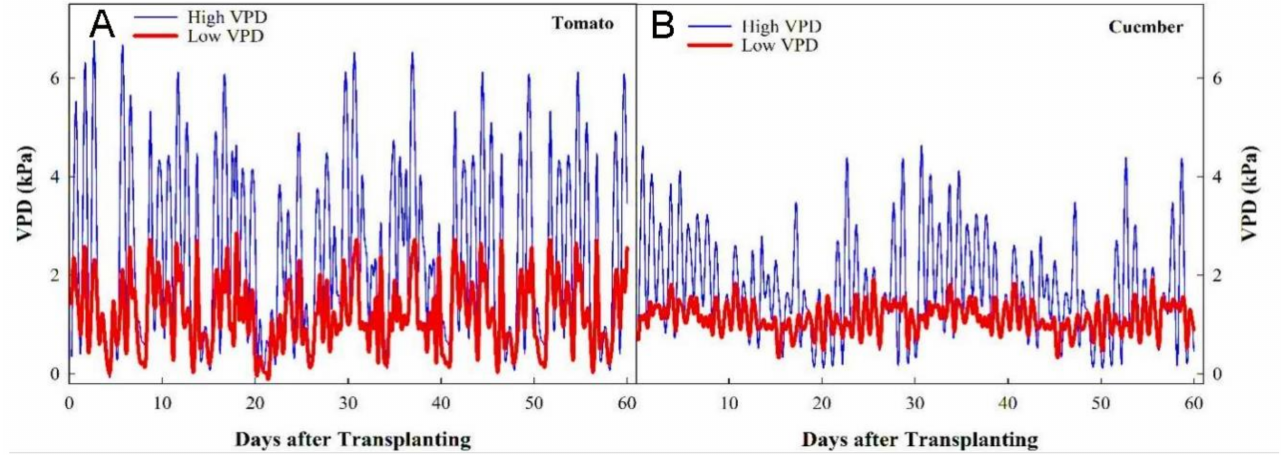
Figure 1. Experimental greenhouse environmental parameters. ( A ): Tomato plants were grown from 7 February 2018 to 8 May 2018. ( B ): Cucumber plants were grown in the same greenhouse from 15 September 2018 to 8 November